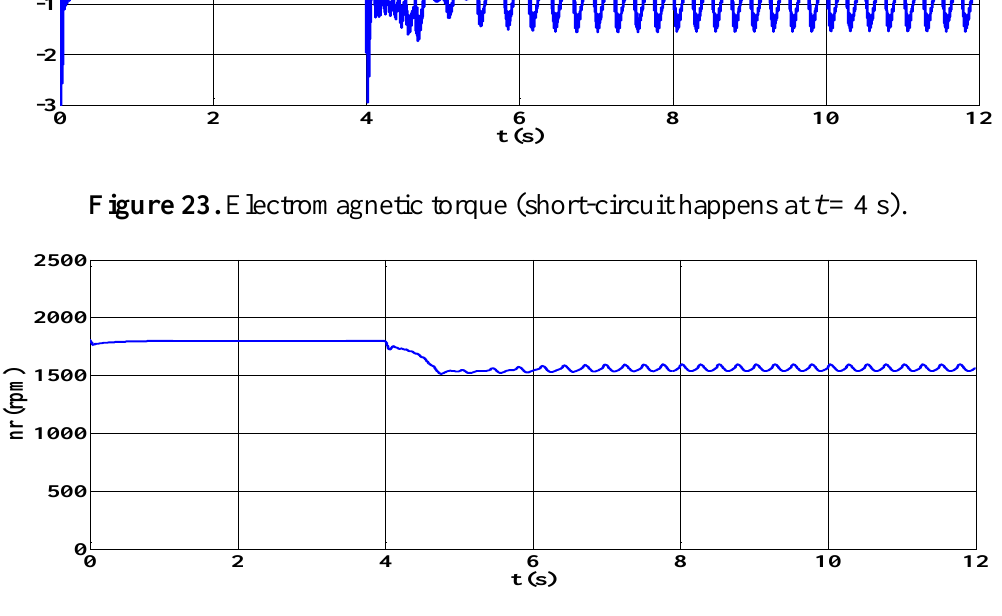
Figure 24. Rotor speed n r (short-circuit happens at t = 4